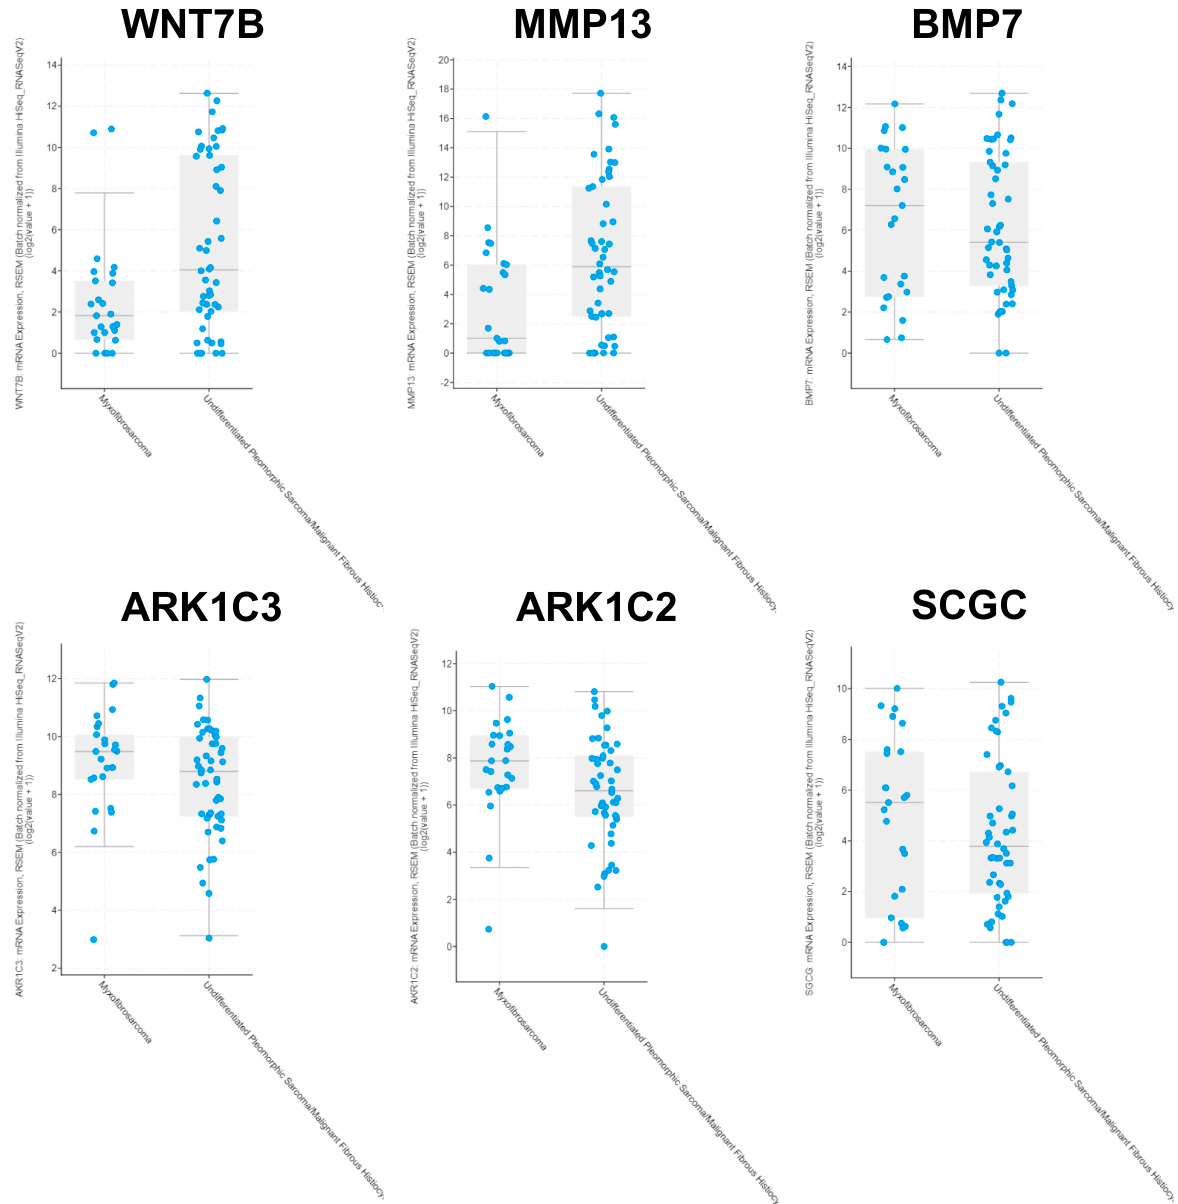
Figure 5. cBioPortal in silico analyses of most relevant differentially expressed genes (DEGs) between MFS and UPS. Box plots showing mRNA expression of selected DEGs in MFS and UPS patients according to the Sarcoma database TCGA, PanCancer Atlas, including 50 UPS and 25 MFS patients.